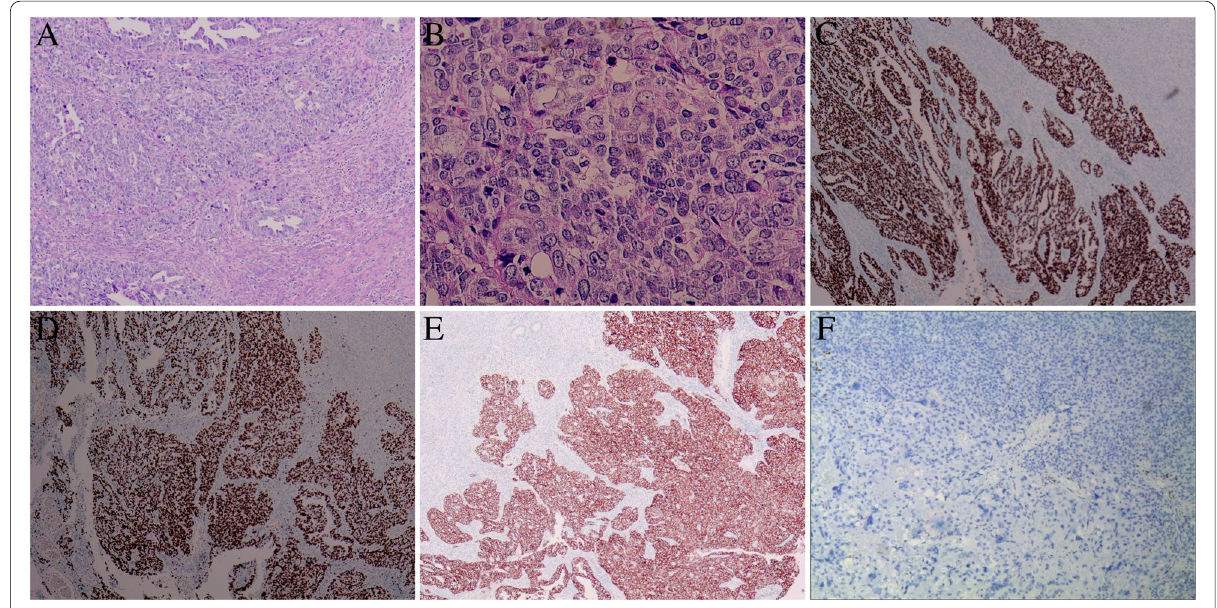
Fig. 2 A Serous carcinoma showed glandular, papillary formation, and solid sheets. (Hematoxylin and eosin stain, original magnification, B : Serous carcinoma showed marked nuclear atypia, distinct nucleoli and frequent mitotic figures. (Hematoxylin and eosin stain, original magnification, 400) C : Aberrant p53 over-expression in serous carcinoma. (The immunohistochemical stain, original magnification, × High Ki67 index in srous carcinoma. (The immunohistochemical stain, original